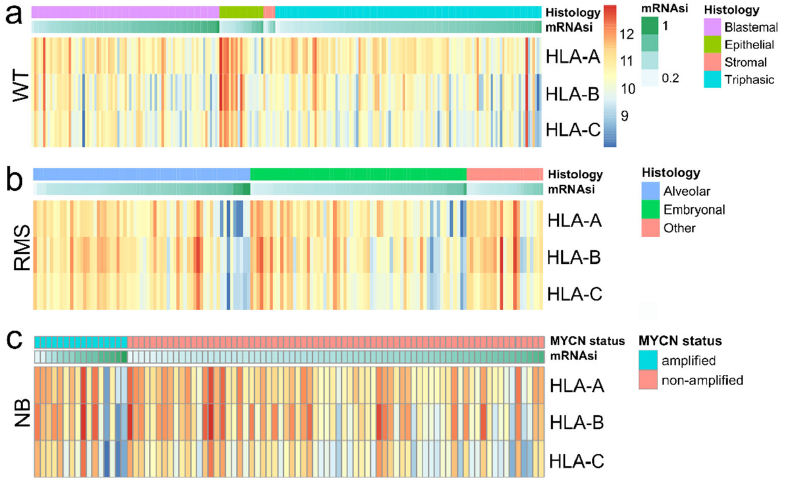
Figure 3. Tumors with a high stemness index (mRNAsi) are associated with low HLA-A/-B/-C expres- sion independent of clinical–pathological data such as histological subtype and MYCN status. Gene- expression heatmaps of HLA-A, HLA-B, and HLA-C stratified for mRNAsi and clinical–pathological data in ( a ) WT (GSE31403, n = 224), ( b ) RMS (GSE92689, n = 158), and ( c ) NB (GSE16476, n = 88). Co- horts were first subdivided into histological and molecular subtype as shown, and subsequently sorted according to the mRNAsi level ranging between 0 and 1 (see Methods). Significant observations (Spear- man’s rank correlation coefficient) are shown as follows—WT (GSE31403, n = 224): HLA-A ( r = − 0.44, p < 0.001), HLA-B ( r = − 0.38, p < 0.001), HLA-C ( r = − 0.25, p < 0.001); RMS (GSE92689, n = 158): HLA-A ( r = − 0.55, p < 0.001), HLA-B ( r = − 0.44, p < 0.001), HLA-C ( r = − 0.45, p < 0.001); NB (GSE16476, n = 88): HLA-A ( r = − 0.41, p < 0.001), HLA-B ( r = − 0.38, p < 0.001), HLA-C ( r = − 0.4, p < 0.001). Results were validated within further cohorts as shown in Figure 2 and Supplementary Table S2. Abbreviations: neuroblastoma, NB; rhabdomyosarcoma, RMS; Wilms tumor,